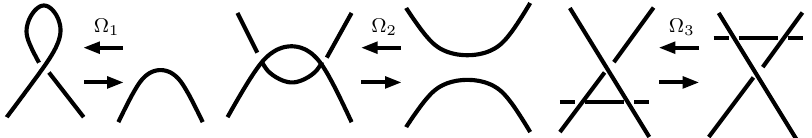
Fig. 2. Two diagrams of equivalent links are moved to each other by a finite sequence of three moves Ω 1 , Ω 2 and Ω 3